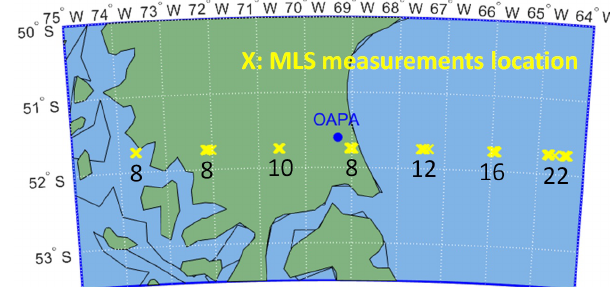
Figure 3. MWR location (blue dot, OAPA) and MLS measurement location (yellow crosses) used in the inter-comparison. The num- bers below crosses indicate the quantity of MLS